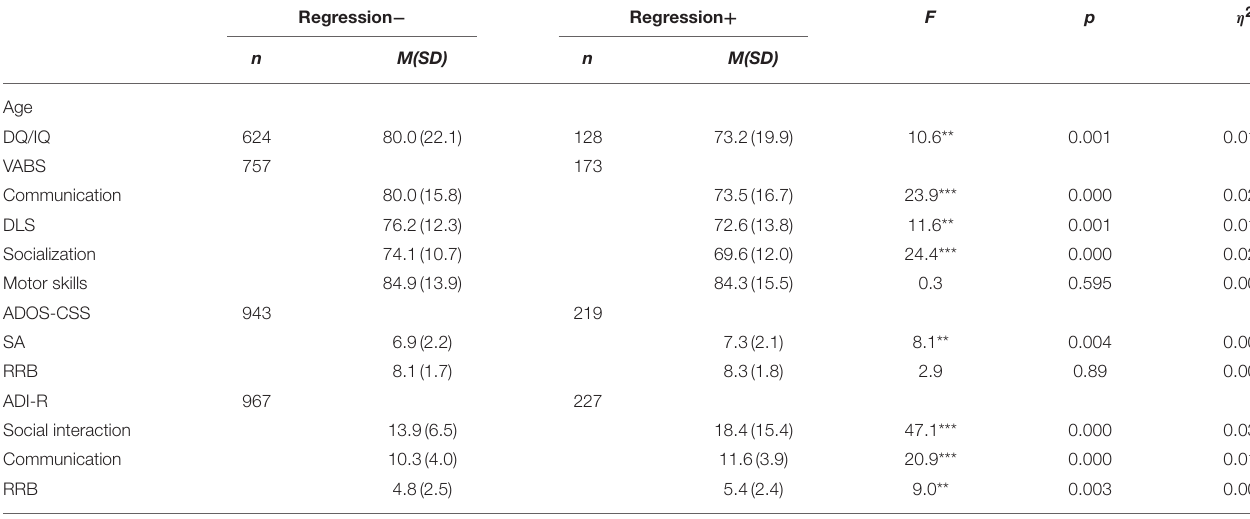
TABLE 3 | Mean and SD of cognitive scores, VABS scores and autism severity measures for the groups with and without a history of developmental regression. Regression − Regression + F p η 2